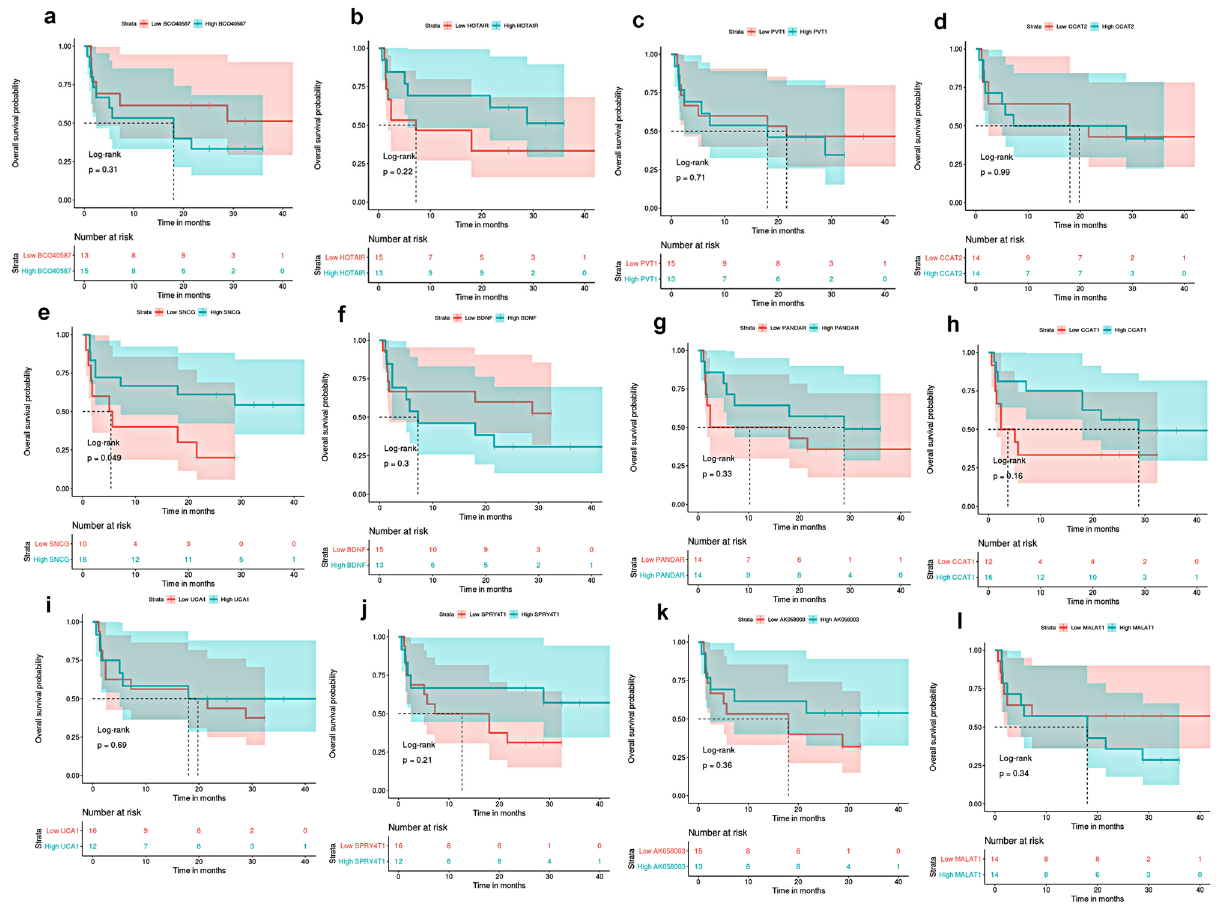
Figure 4. Kaplan Meier overall survival analysis of metastatic breast cancer patients in relation to lncRNAs (BCO40587, HOTAIR, PVT1, CCAT2, PANDAR, CCAT1, UCA1, SPRY4-IT1, AK058003 and MALAT1) and mRNAs (SNCG and BDNF) expression